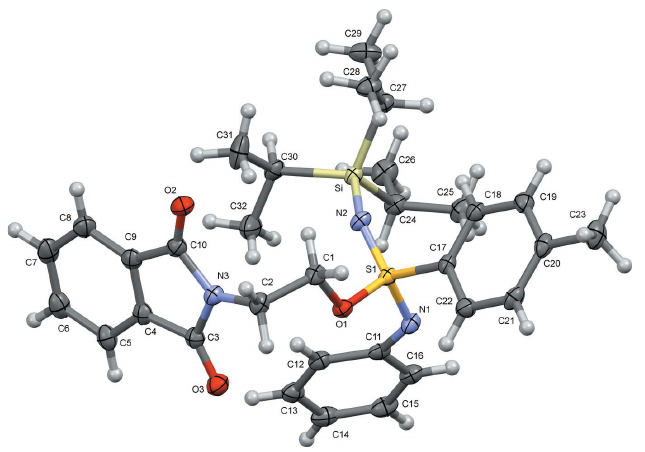
Figure 1 The molecular structure of 2-(1,3-dioxoisoindolin-2-yl)ethyl-4-methyl- N - phenyl- N 0 -(triisopropylsilyl)benzenesulfondiimidoate ( 1 ) with the atomic numbering scheme. Displacement ellipsoids are drawn at the 50% probability level.